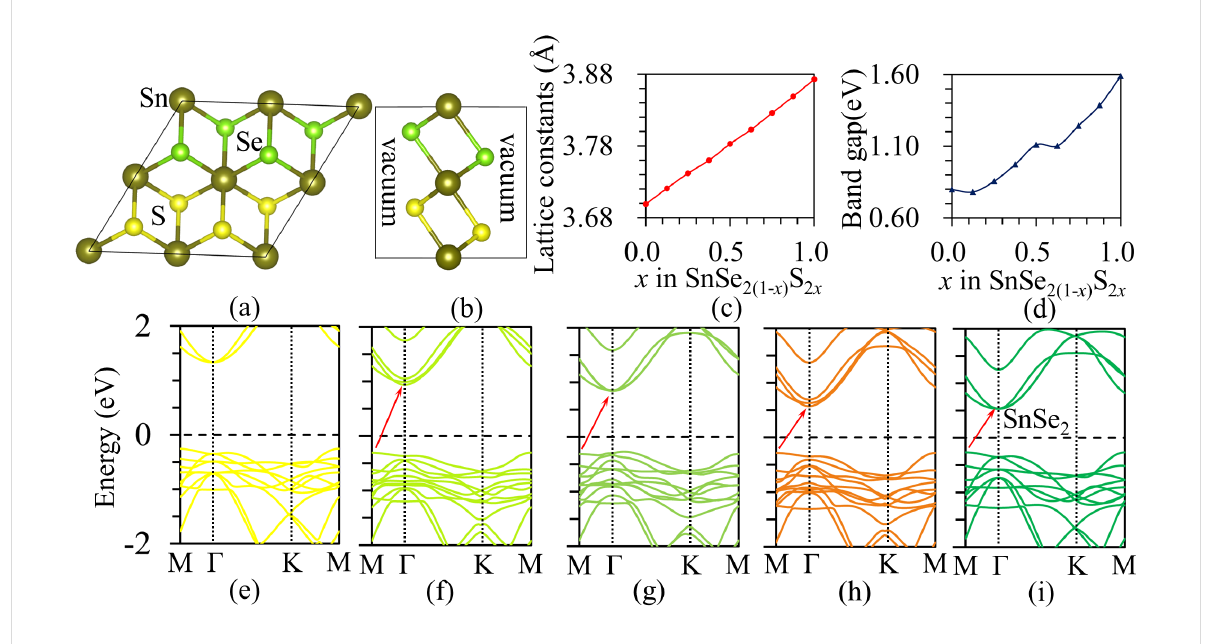
Figure 1: (a) Top view and (b) side view of monolayer SnSeS. (c) Variation of the lattice constant as a function of Se content in monolayer SnSe 2(1 − x ) S 2 x . (d) Band gaps as a function of Se content in monolayer SnSe 2(1 − x ) S 2 x . (e–i) The band structures of monolayer SnSe 2(1 − x ) S 2 x with x equal to (e) 1.0, (f) 0.75, (g) 0.50, (h) 0.25 and (i) 0.0. The arrows indicate the indirect band gap for a given